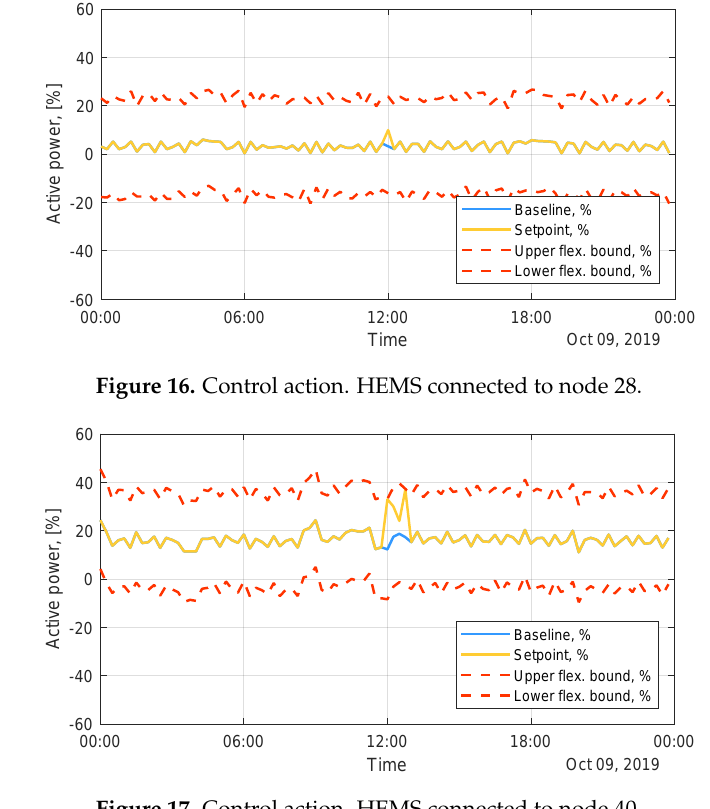
Figure 17. Control action. HEMS connected to node 40.